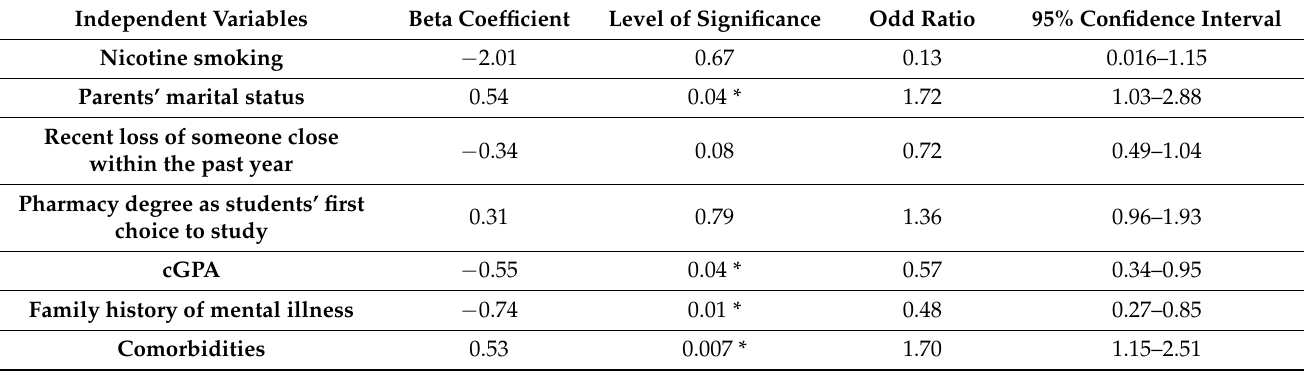
Table 4. Binary logistic regression analysis predicting depression